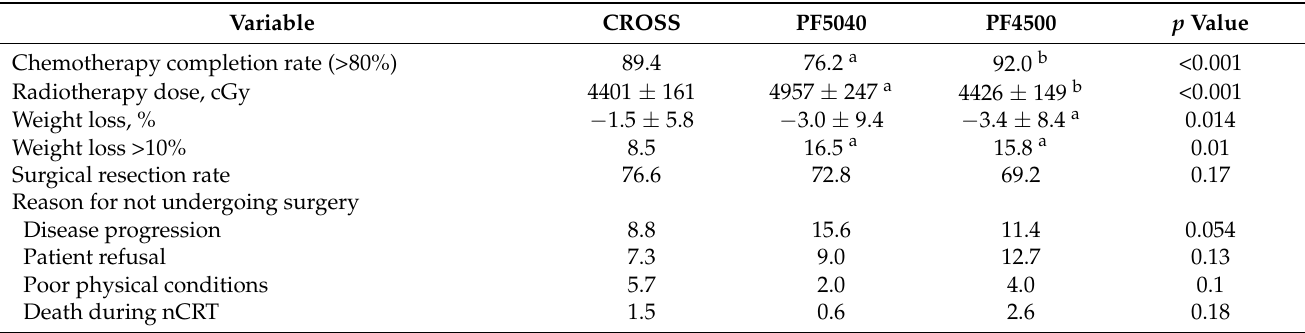
Table 2. Preoperative outcomes of patients in the GBM-IPTW cohort.